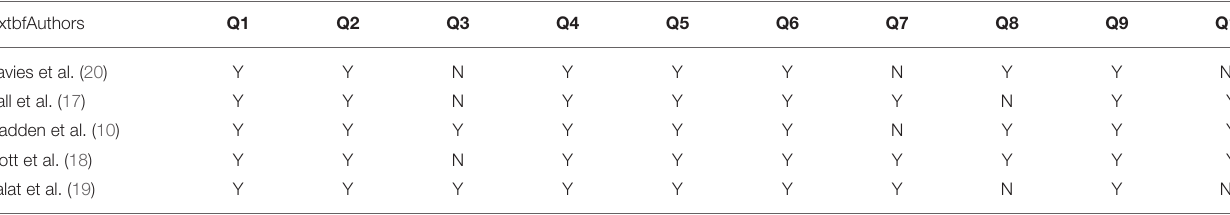
TABLE 2 | Critical appraisal of included studies based on JBI I Critical Appraisal Checklist for Case series.